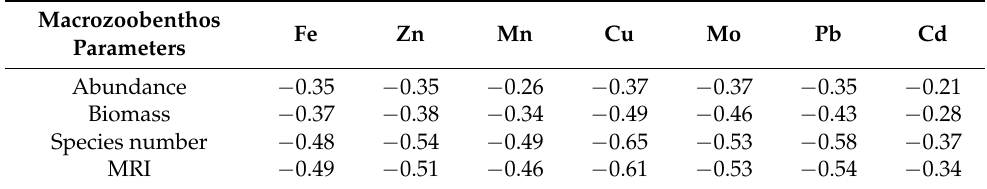
Table 8. Pearson’s coefficients of correlations between macrozoobenthos parameters and HMs in water.